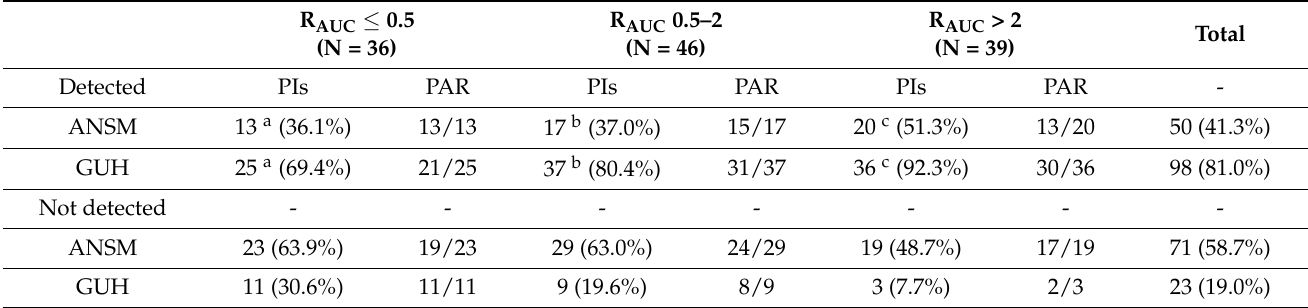
Table 3. Comparison of PIs and PARs for DDI-Predictor, the ANSM thesaurus and the GUH tables. a p < 0.05; b p < 0.001; c p <